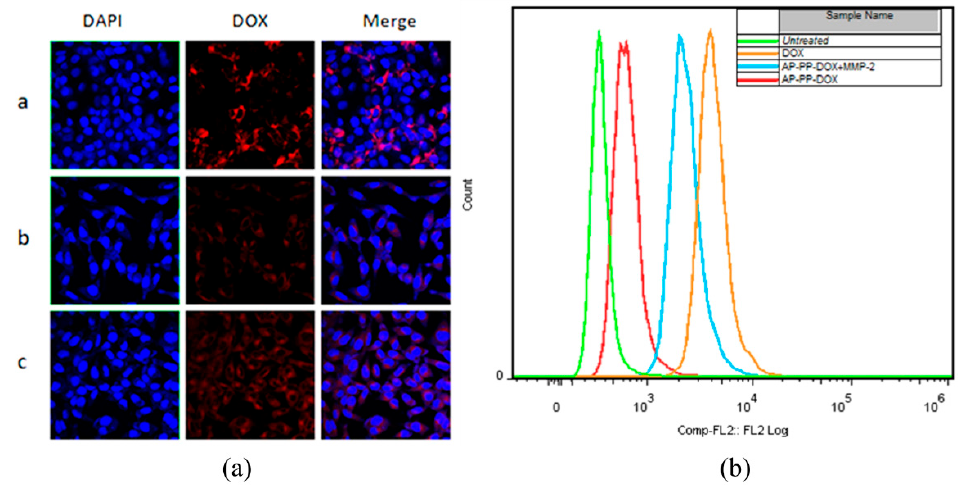
Figure 6. Cellular uptake of the nanoparticles after 2 h of incubation with the A549 cells, determined by LSCM ( a ) and FACS ( b ). a, Free DOX; b, AP-PP-DOX without MMP2 preincubation; c, AP-PP-DOX with MMP2 preincubation.